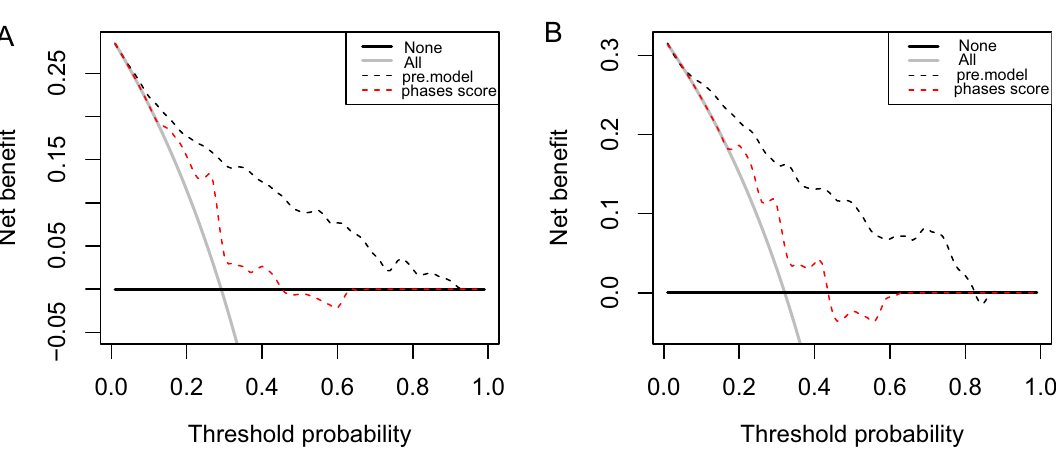
Figure 5. Decision cure analysis of the nomogram. Net benefit was compared between the nomogram and PHASES score instructed treatment. Both in the training ( A ) and testing ( B ) sets, the nomogram instructed treatment gained an even higher net benefit than the PHASES system in our series. All: all aneurysms were treated; None: no aneurysm was treated; Phases score: treatment decision was instructed by PHASES score; Pre. model: treatment decision was instructed by the